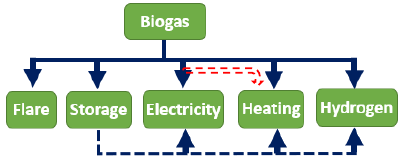
Figure 4. Biogas utilisation in WWTPs. Table 6. Characteristics of biogas power generation